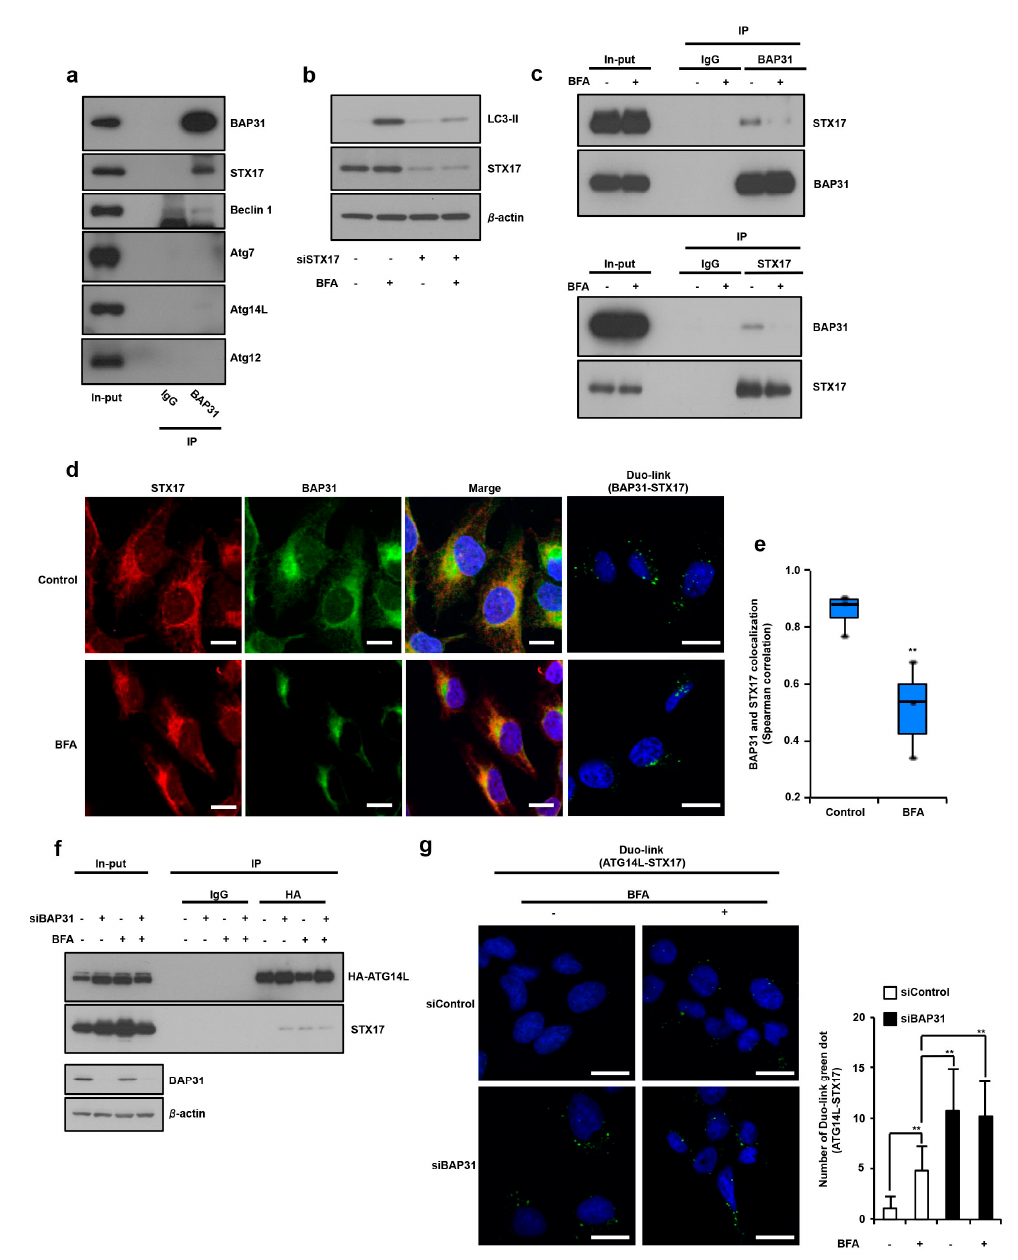
Figure 3. BAP31 interacts with STX17, and disintegration of this complex stimulates STX17 and ATG14L interaction by through BAP31 deficiency. ( a ) U2OS cells were harvested, and the proteins were cross-linked with DSP prior to the protein extraction. A co-immunoprecipitation assay was performed with cell lysates, followed by western blotting, using the indicated antibodies. ( b ) STX17 knockdown suppressed ER stress-induced autophagy. U2OS cells were transfected with siControl ( − ) or siBAP31 (+) for 24 h and these cells were then treated with ( − ) or without (+) BFA (1 µg/mL) for 18 h. Cells were subjected to immunoblotting using indicated antibodies. ( c ) BAP31 and STX17 interaction is suppressed by ER stress. U2OS cells were treated with or without BFA (1 µg/mL) for 12 h. Co-immunoprecipitation was performed using the same procedure described in Figure 3a. These experiments were repeated two times ( a – c ). ( d ) U2OS cells were treated with BFA (1 µg/mL) for 12 h and subjected to immunostaining analysis using antibodies to BAP31 (green) and STX17 (red). Merged images are also shown, and co-localization is indicated in yellow. Blue represents nuclear DAPI staining (scale bar, 10 µm). Representative images of DuoLink using BAP31 and STX17 (right panel) antibodies in U2OS cell. ( e ) Co-localization analysis using the Fiji Coloc 2 (Spearman correlation) was